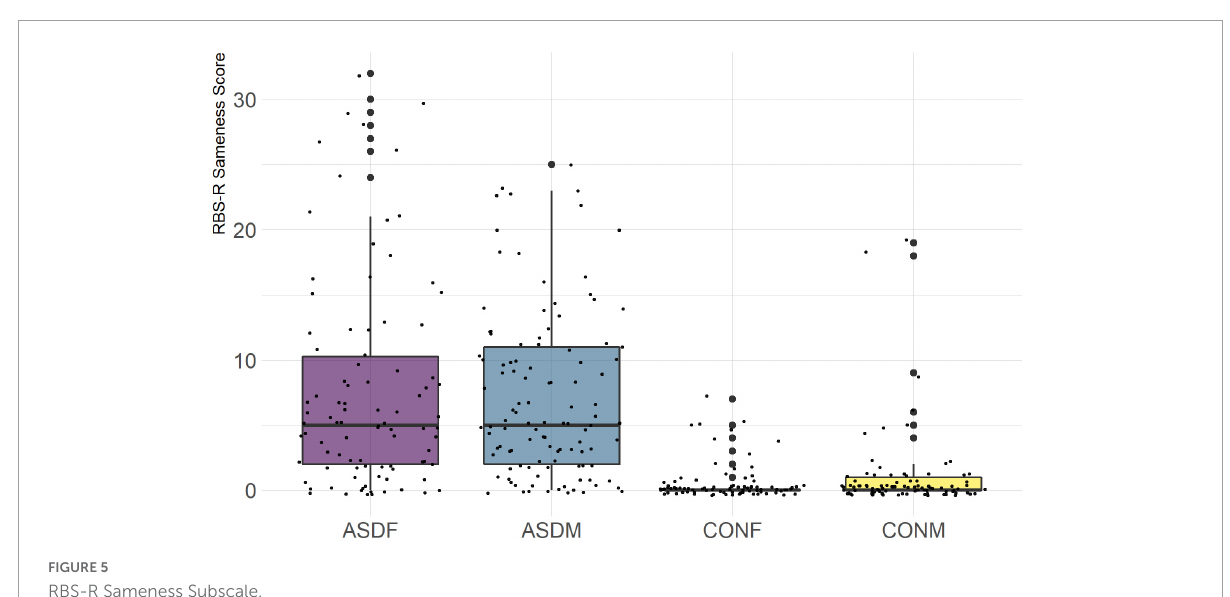
FIGURE5 RBS-R Sameness